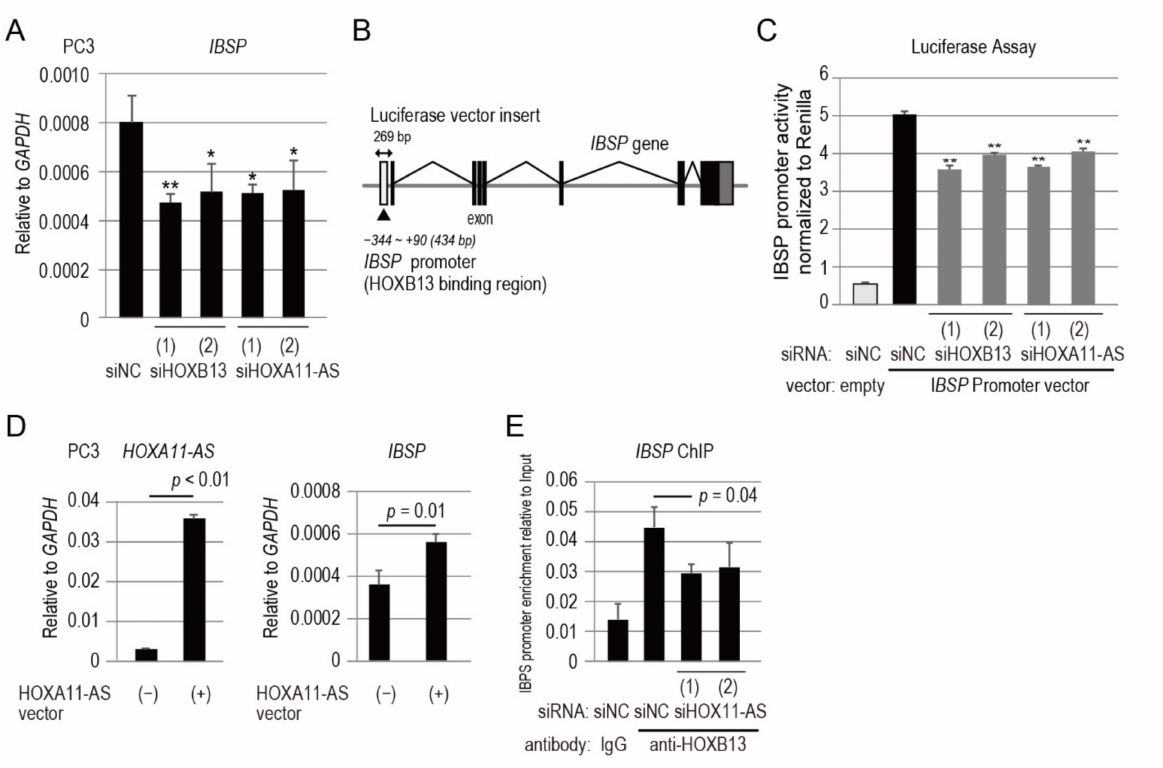
Figure 4. IBSP promoter is directly regulated by HOXB13 in combination with HOXA11-AS . ( A ) IBSP expression analysis by qPCR in PC3 cells transfected for 48 h with siHOXB13 or siHOXA11-AS. ( B ) IBSP exons, promoter region with HOXB13 binding site, and luciferase vector insert are shown. ( C ) Luciferase assay of PC3 cells co-transfected with siHOXB13 or siHOXA11-AS and luciferase vector. Vectors with negative control siRNA (siNC) were used as controls. Values were normalized to Renilla luciferase activity. Data represent mean ± standard deviation. ( D ) Expression analysis of HOXA11-AS and IBSP by qPCR in PC3 cells transfected for 48 h with or without HOXA11-AS expression vector. ( E ) ChIP analysis of HOXB13 in IBSP promoter region in PC3 cells transfected for 24 h with siHOXA11-AS. IBSP promoter enrichment relative to input was measured by qPCR. qPCR analyses were performed in triplicate ( n = 3). Expression levels are presented relative to values of GAPDH , used as a reference gene. Values represent mean ± standard deviation. Statistical significance was determined by unpaired t -tests. *, p < 0.05. **, p <